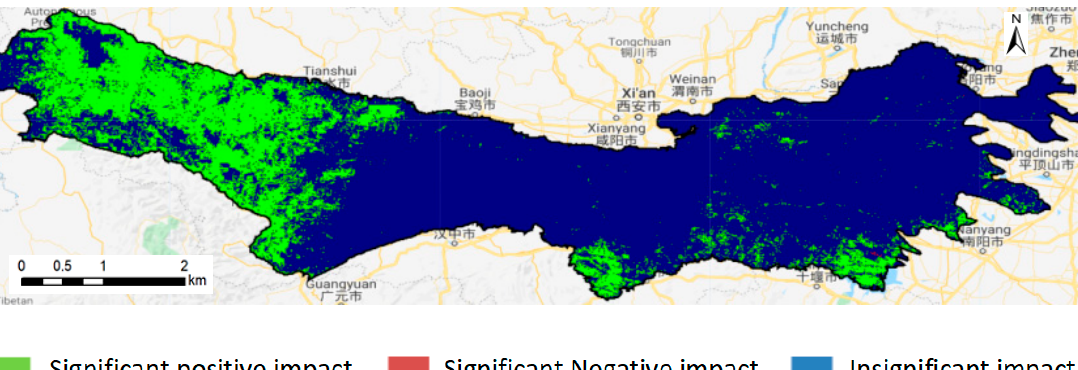
Figure 10. The spatial distribution of NDVI residuals in Qin Mountains from 1987 to 2019. Table 1. The Statistics of NDVI residuals in Qinling Mountains from 1987 to 2019 (%). Residuals Trend > 0 Residuals Trend < 0